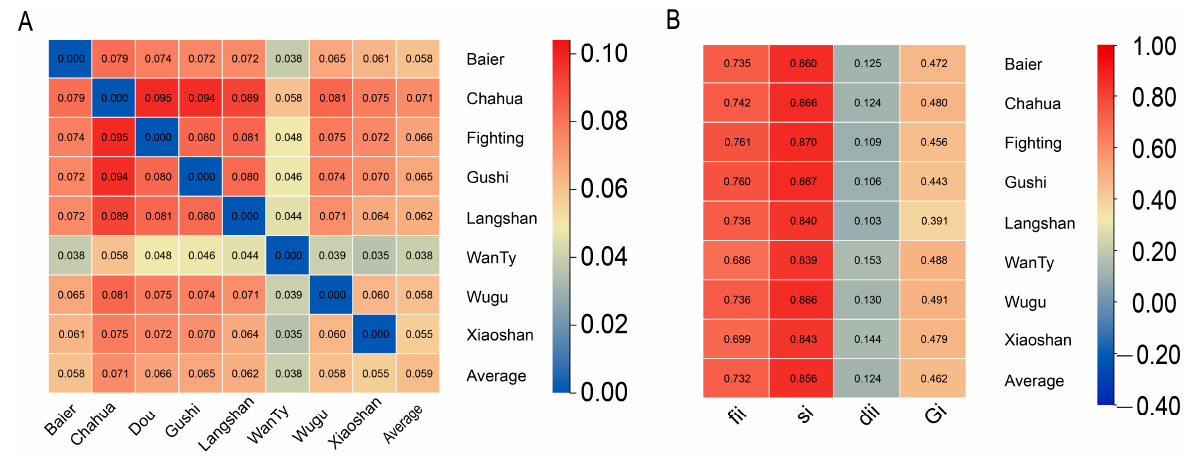
Figure 1. ( A ) MDS analysis and ( B ) phylogenetic tree of the eight indigenous breeds, ( C ) cross-vali- dation (CV) error rate and ( D ) population structure of the eight indigenous breeds.